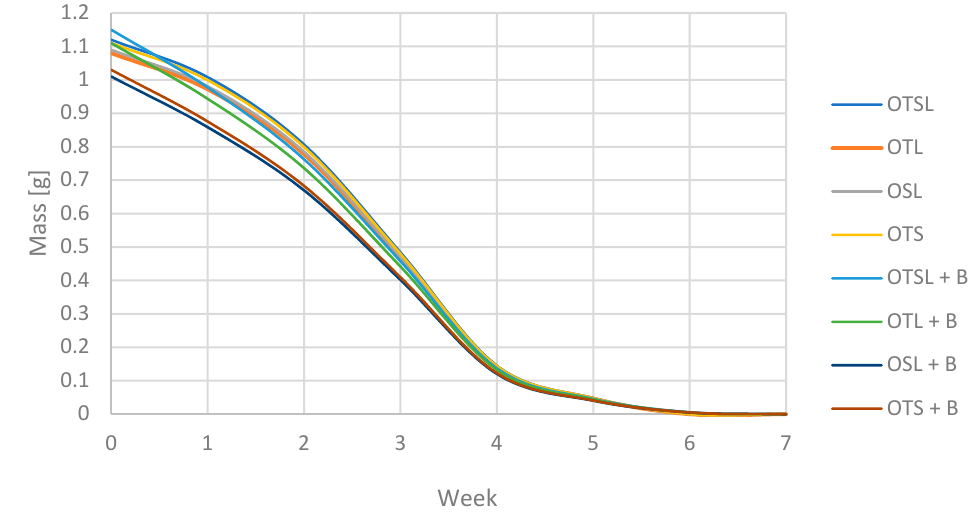
Figure 3. Change in the mass of biodegradable products after baking.